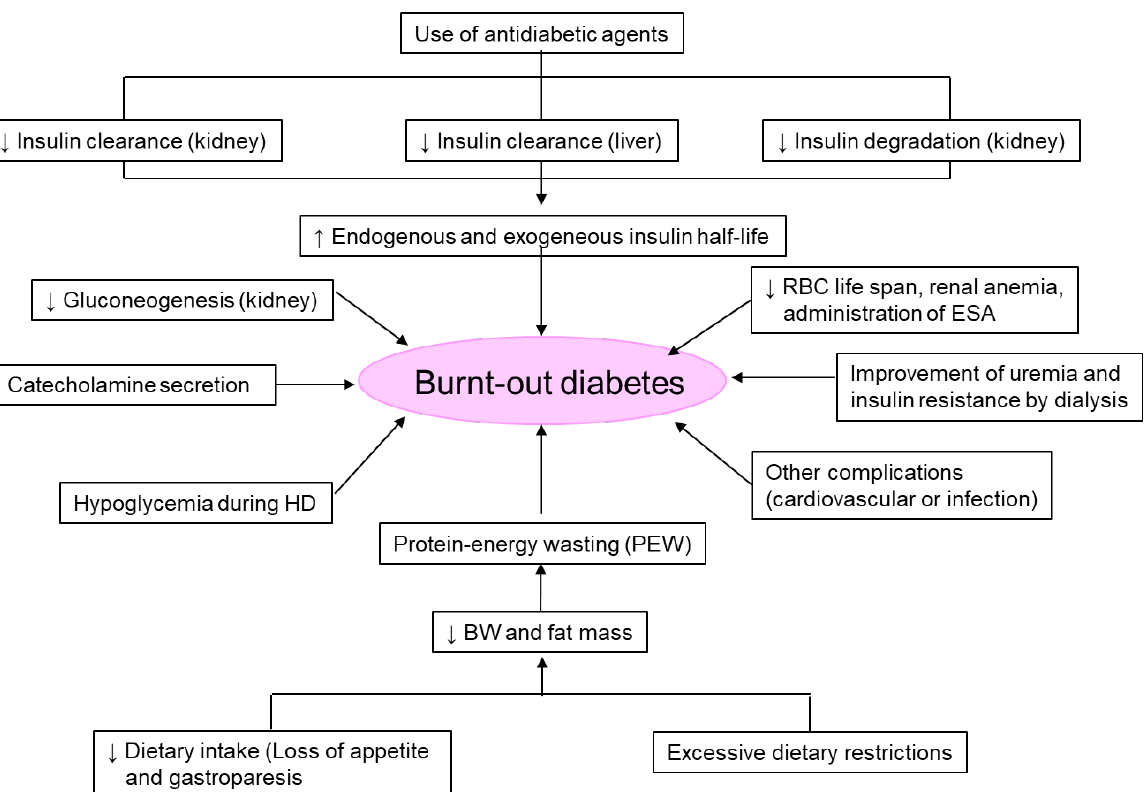
Figure 5. Leading factors of ‘burnt-out diabetes’. BW, body weight; ESA, erythropoiesis stimulating agent; HD, hemodialysis; RBC, red blood cell.